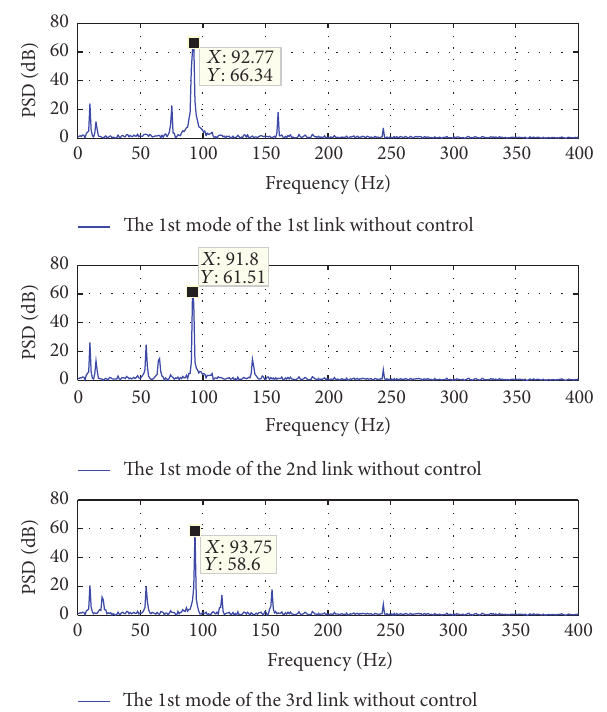
Figure 13: The PSD plot of the first mode of the three links without control.